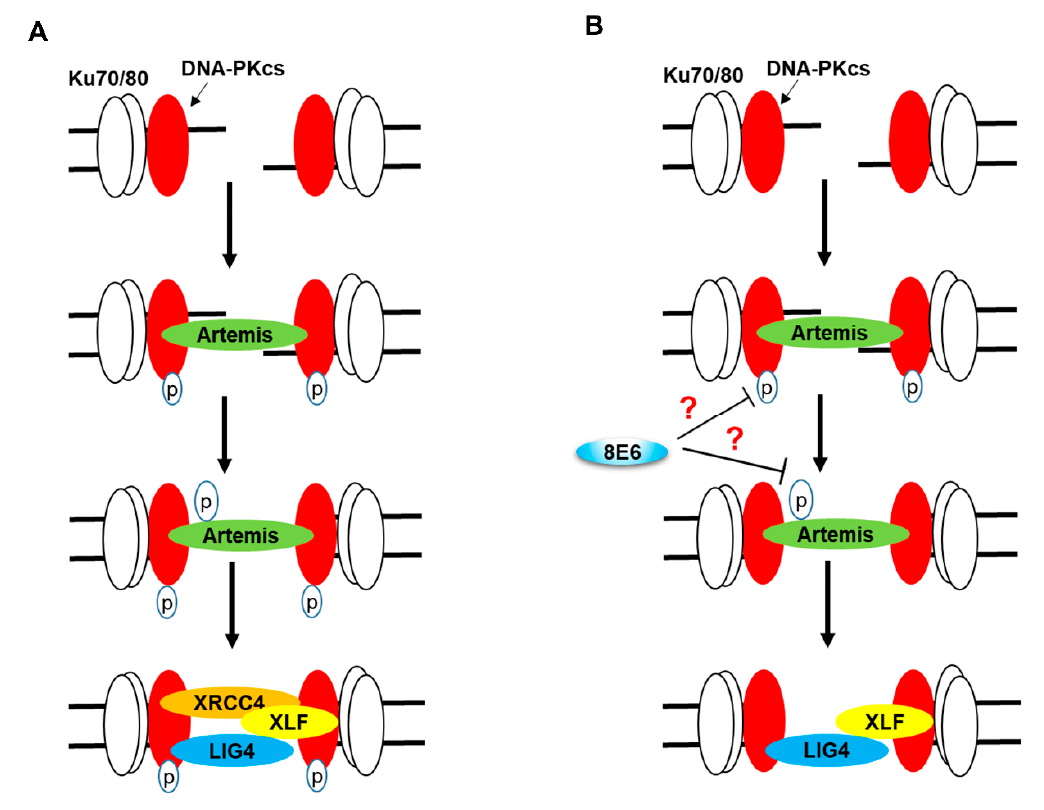
Figure 7. NHEJ in Cells with and without β -HPV 8E6. ( A ) Schematic of canonical NHEJ pathway. DNA-PK holoenzyme